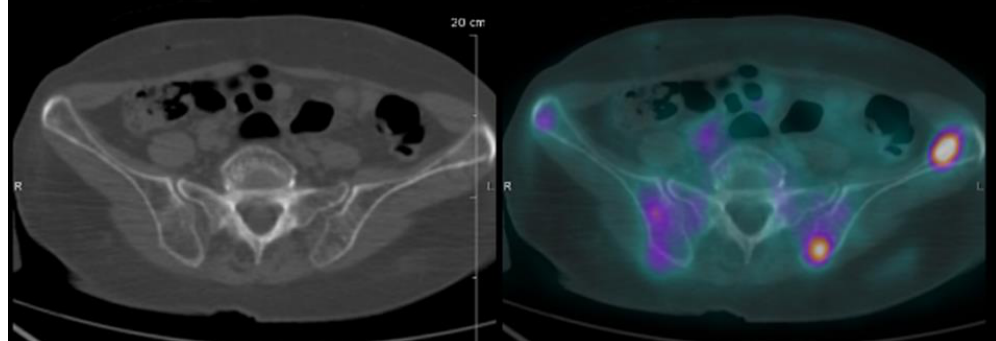
Figure 5. FDG-PET/CT images of an IgG SMM patient. Two FDG-positive focal lesions of the iliac